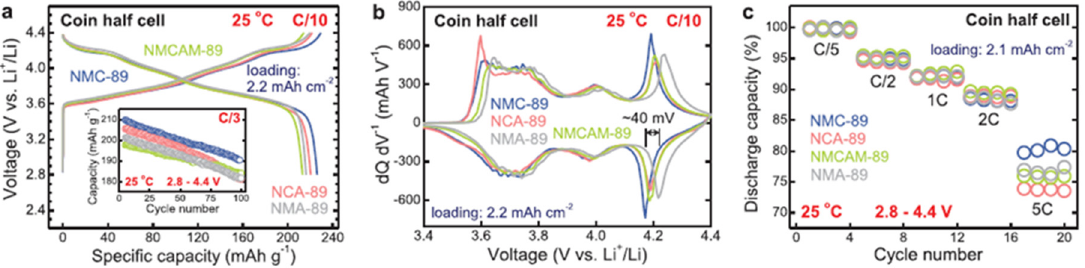
Figure 8. Electrochemical performance of NMA89 compared with NMC89, NCA89 and NCMAM89. ( a ) Galvanostatic charge-discharge profile curves at 0.1 C, ( b ) dQ/dN curves, and ( c ) rate capability performance. Image is adapted with permission from authors [96]. Reproduced from Advanced Materials, the name of the publisher: John Wiley and Sons. NMA with various compositions, namely, LiNi 0.80 Mn 0.13 Al 0.07 O 2 , LiNi 0.85 Mn 0.09 Al 0.06 O 2 ,